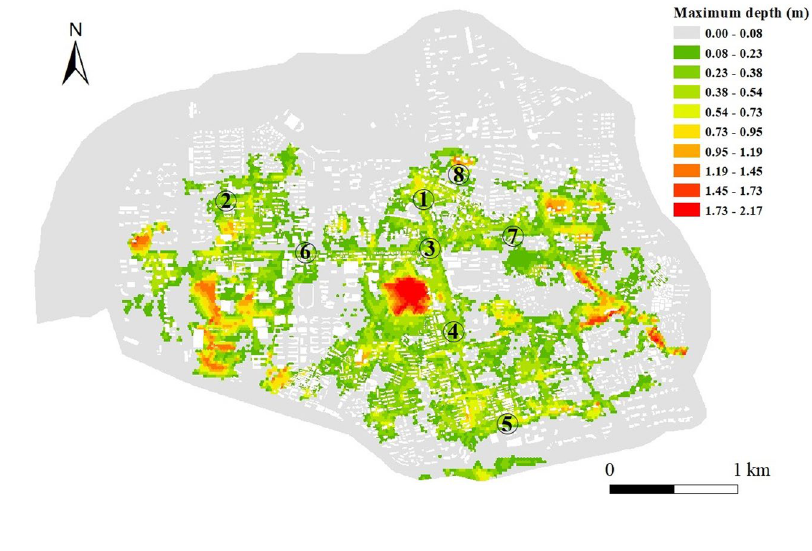
Table 2 Comparison of the observed and simulated water depths in the Haidian Island study area on Hainan Island,